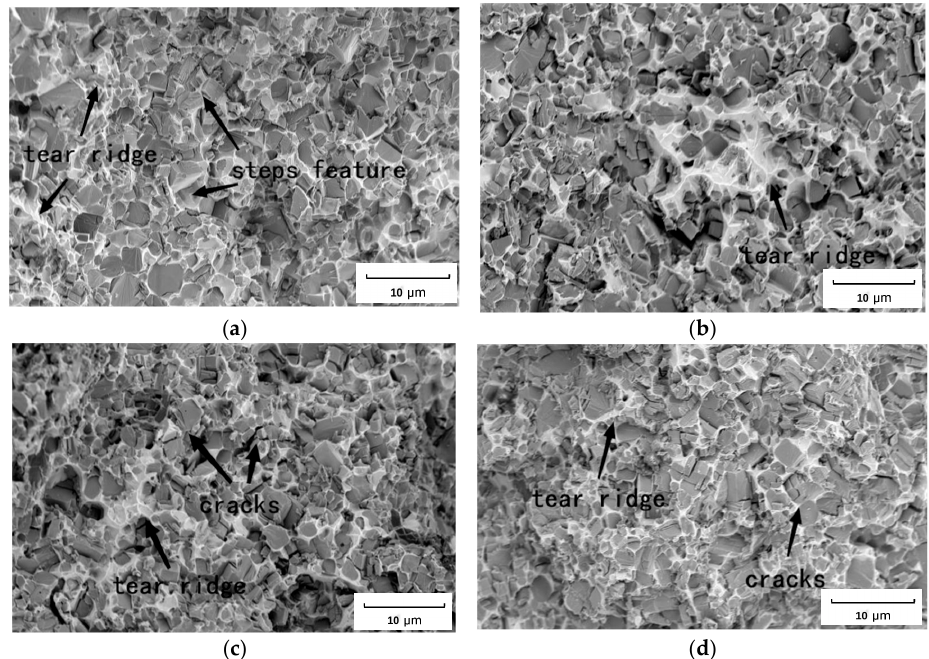
Figure 8. Fracture section of TiC cermet with different heat input: ( a ) sintered; ( b ) 3.4 KJ/cm; ( c ) 6.2 KJ/cm; ( d ) 7.9 KJ/cm. ( c ) 6.2 KJ/cm; ( d ) 7.9